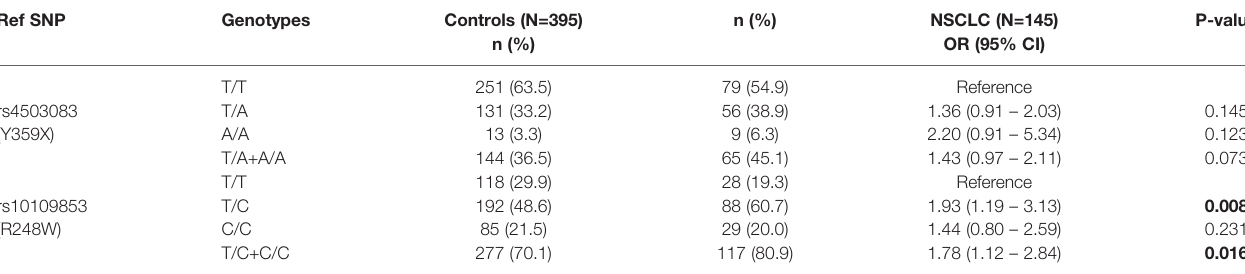
TABLE 1 | Association test results of IDO2 genotypes and the risk of non-small-cell lung cancer (NSCLC). Ref SNP